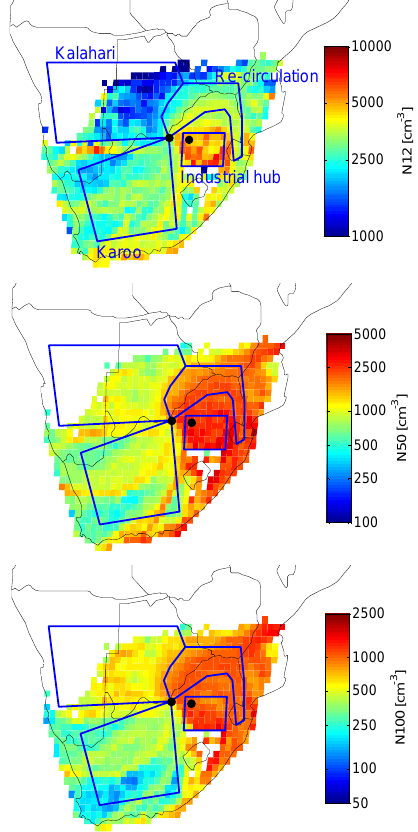
Fig. 12. Mean N 12, N 50 and N 100 for the four defined source regions at Botsalano. Black dots indicate Botsalano on the left and the later measurement location, Marikana, on the